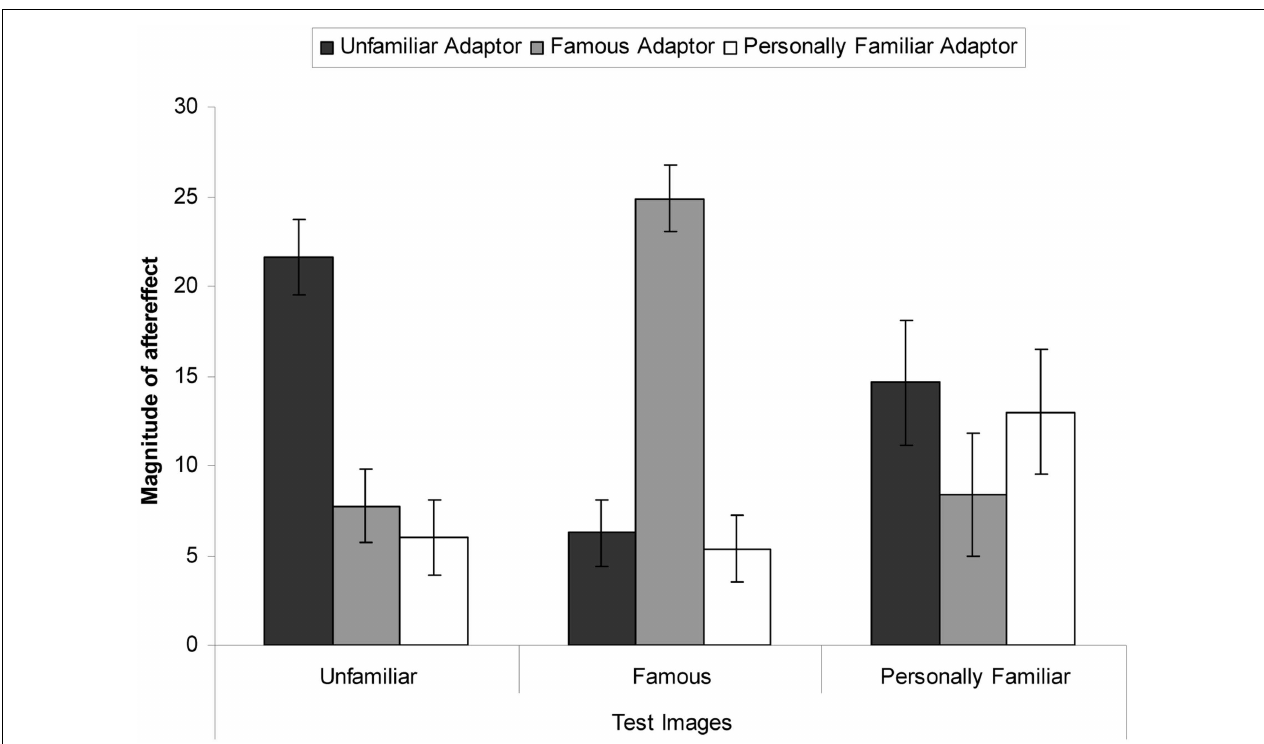
FIGURE 2 | Magnitude of aftereffect (mean number of test faces perceived to be distorted post-adaptation subtracted from the mean number of faces perceived to be distorted at baseline), for each image-type for every adaptor type. Error bars show standard